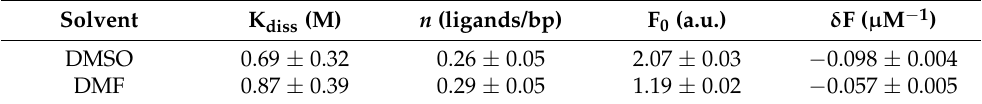
Table 4. Fitting parameters obtained by interpolation of the experimental binding isotherms of Figure 6 with the independent binding site model, Equation (1). Solvent K diss (M) n (ligands/bp) F 0